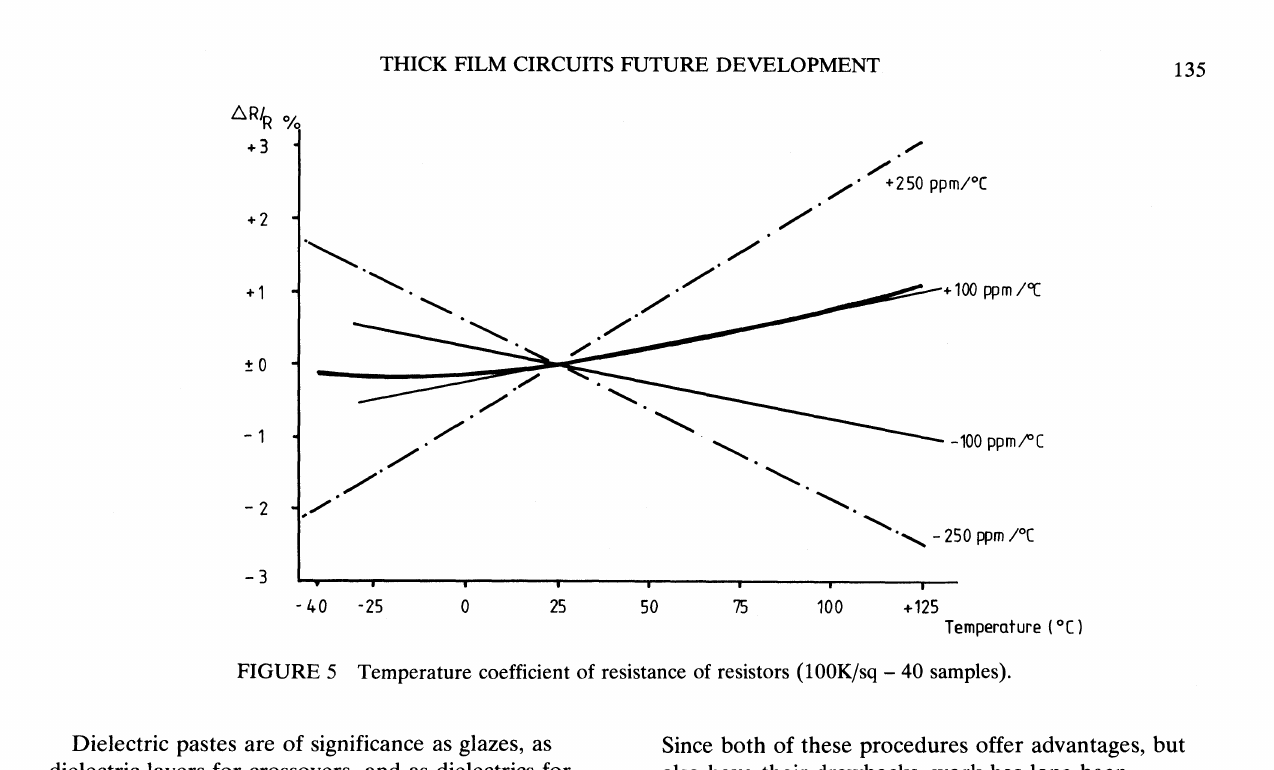
FIGURE 5 Temperature coefficient of resistance of resistors (100K/sq -40